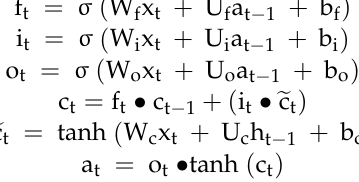
( b ) Figure 6. Schematic Diagram ( a ) Stacked Bi–LSTM structure. ( b ) Stacked Encoder–Decoder Archi- tecture.